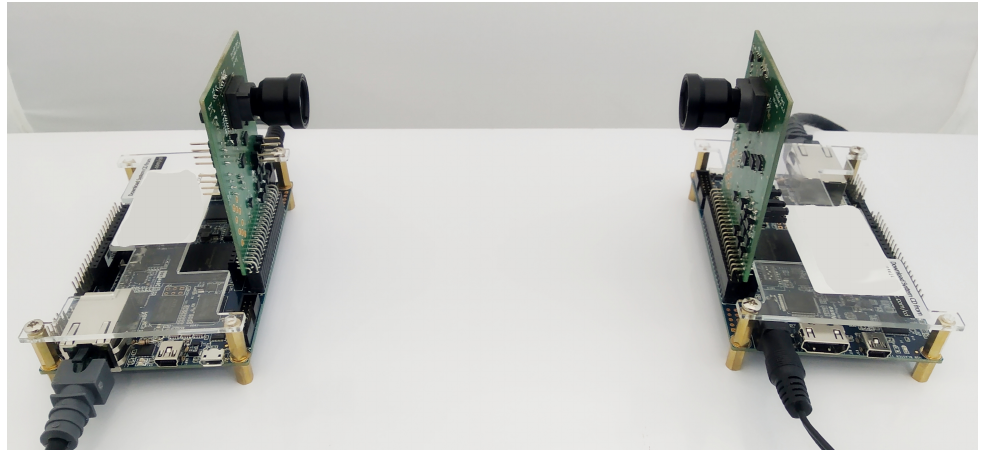
Figure 13. Camera setup for the method evaluation.